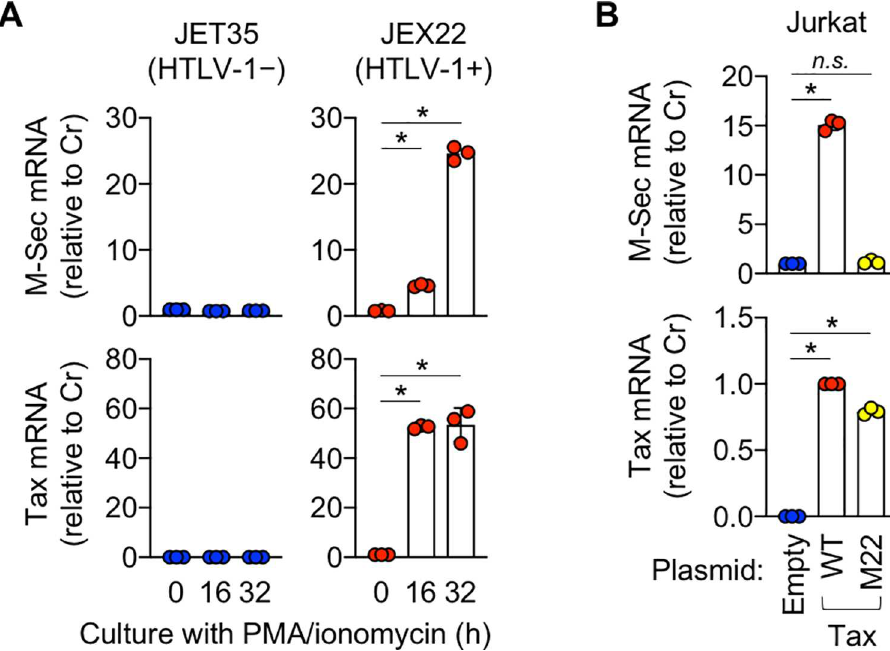
Fig 3. Induction of M-Sec expression by Tax in Jurkat cells. ( A ) The control JET35 (left) or HTLV-1-infected JEX22 cells (right) were left un-stimulated or stimulated with PMA and ionomycin for 16 or 32 h, and analyzed for the expression of M-Sec- (upper) and Tax mRNA (lower) by qRT-PCR. The expression levels are shown by setting the value of un-stimulated cells as 1 (n = 3). � p < 0.05. ( B ) Jurkat cells were nucleofected with the empty vector, or Tax plasmid expressing wild type (WT) or M22 mutant. After 24 h, the cells were analyzed for the expression of M-Sec- (upper) and Tax mRNA (lower) by qRT-PCR. M-Sec expression levels are shown by setting the value of cells nucleofected with the empty vector as 1 (n = 3). Tax expression levels are shown by setting the value of cells nucleofected with the wild type Tax as 1 (n = 3). � p < 0.05. n . s ., not significant.